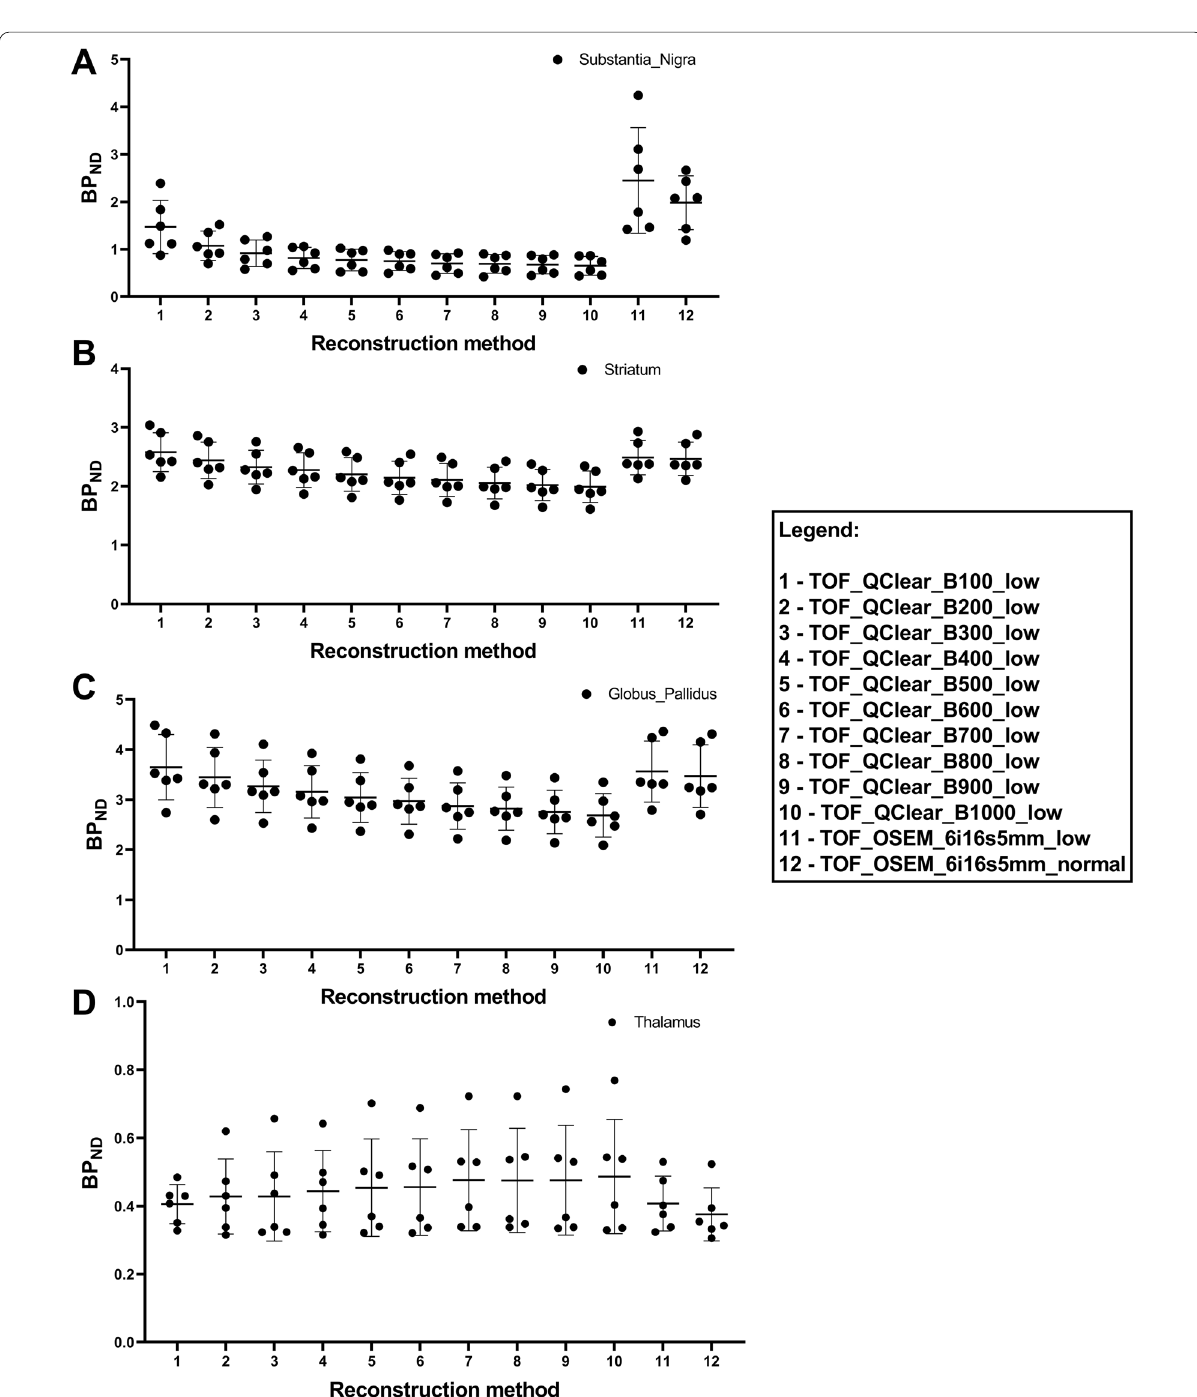
Fig. 5 Graphic layout of the BP ND obtained for the Substantia Nigra ( A ), Striatum ( B ), Globus Pallidus ( C ) and Thalamus ( D ), per reconstruction method. For the Substantia Nigra ( A ), Striatum ( B ) and Globus Pallidus ( C ) as the β value for the Q.Clear reconstructions increases, the mean BP ND decreases. However, for the Thalamus ( D ), as the β value for the Q.Clear reconstructions increases, the mean BP ND